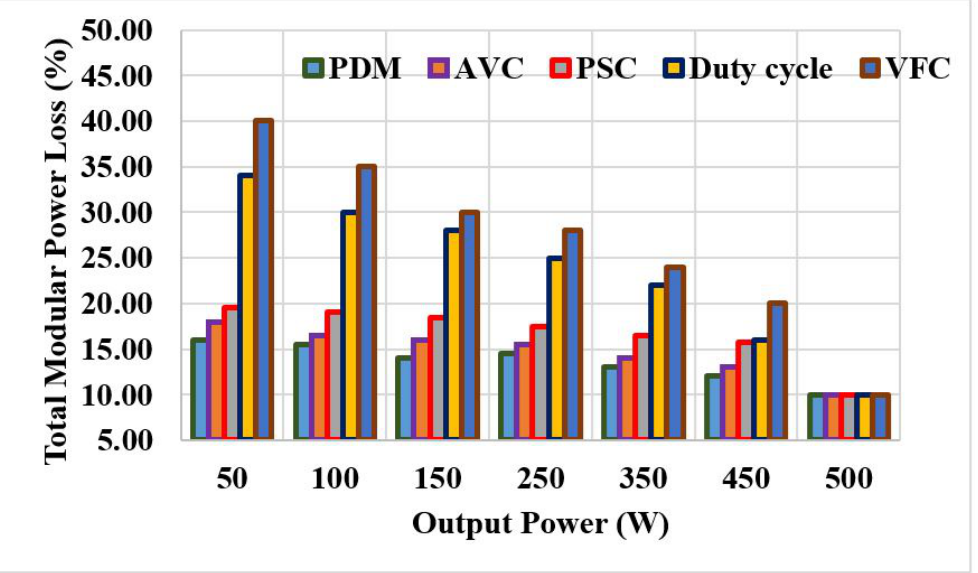
Figure 12. Total modular power